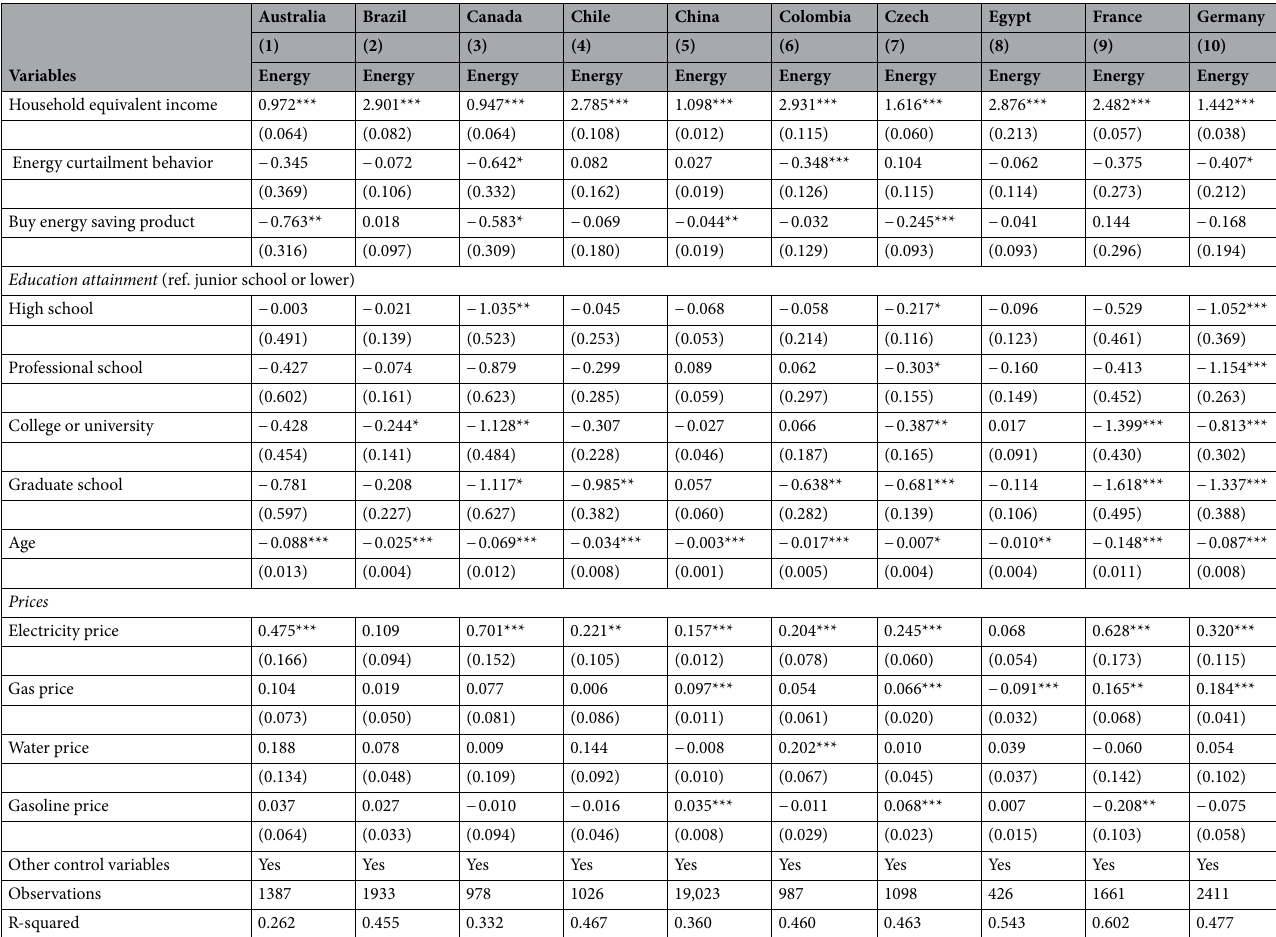
Table 4. Household socioeconomic and demographic determinants of household energy consumption expenditure I. Standard errors in parentheses. *** p < 0.01, ** p < 0.05, * p < 0.1. Other control variables include occupational status, household status, number of children, and gender